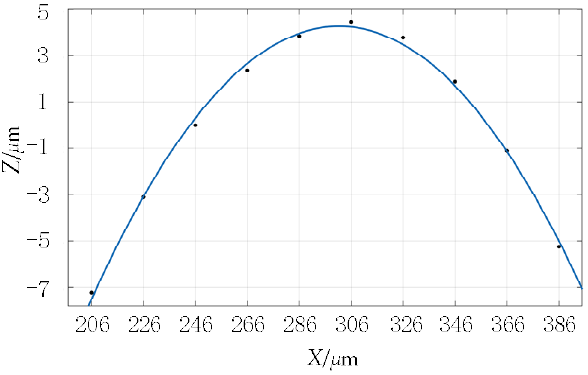
Figure 3. The fitting result of a single asperity.